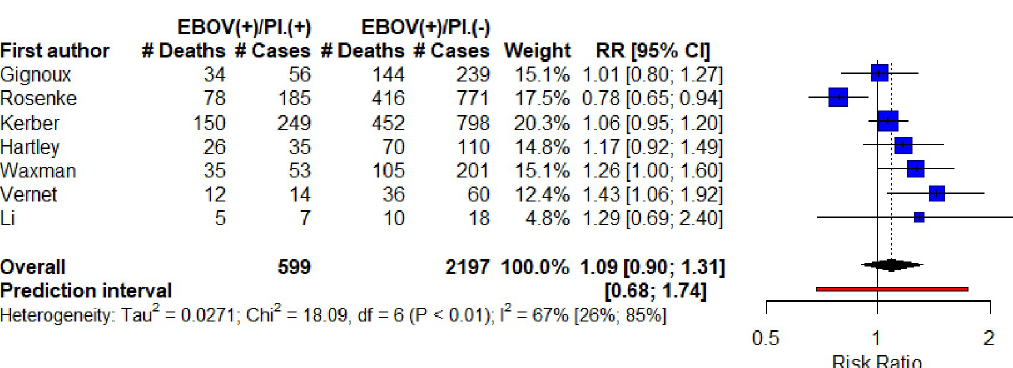
Fig 4. Meta-analysis of unadjusted risk ratio estimates for the effect of Plasmodium infection on EVD-related mortality (all ZEBOV).